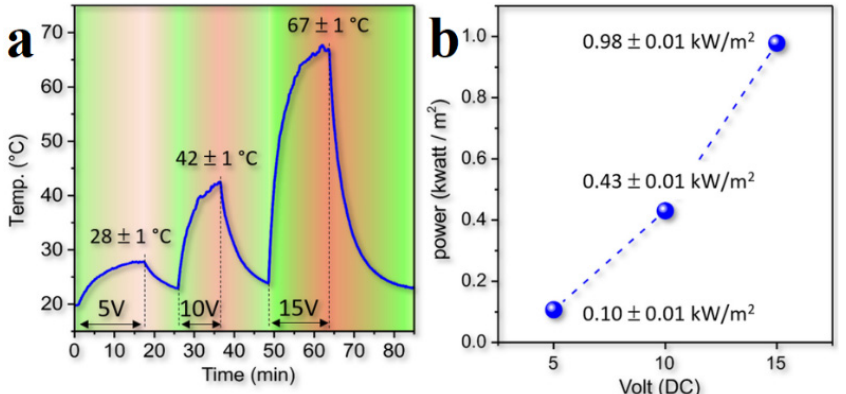
Figure 14. ( a ) Dependence of the temperature value on the applied potential and ( b ) the thermal power density of the composite (kW/m 2 ) as a function of the applied external potential for 0.10 wt.% FLG/PMMA composite. Reprinted with permission from [76].